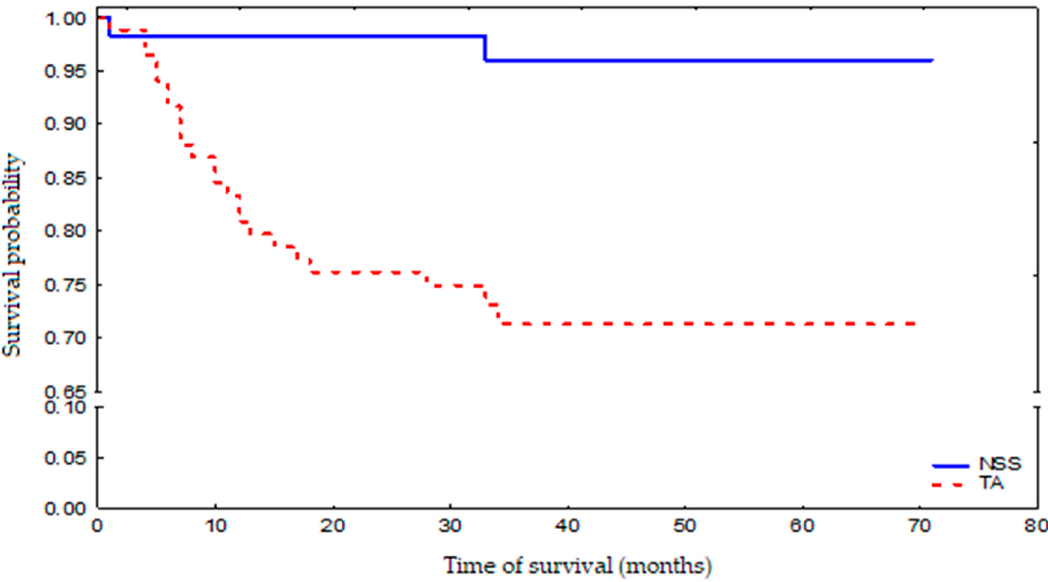
Figure 2. Survival probability in NSS ‐ treated and TA ‐ treated patient groups.